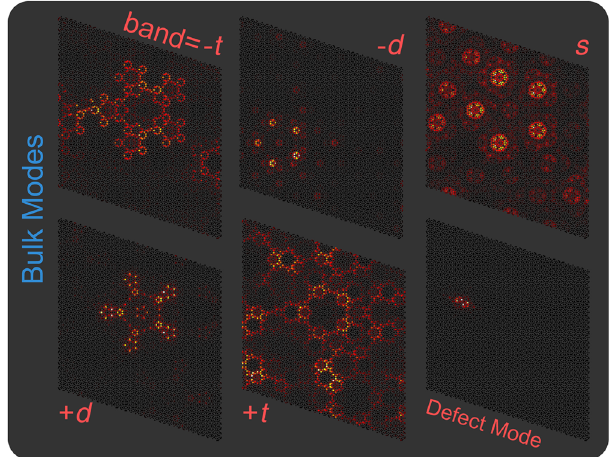
FIG. 3. Bulk states associated with each of the main bands f − t; − d; s; þ d; þ t g of Fig. 2. Note the self-similar structure of the modes; i.e., they are formed by the repetition of a same pattern yet they do not extend over the entire lattice. Bottom right: A defect mode localized at one of the two mismatches of the Penrose